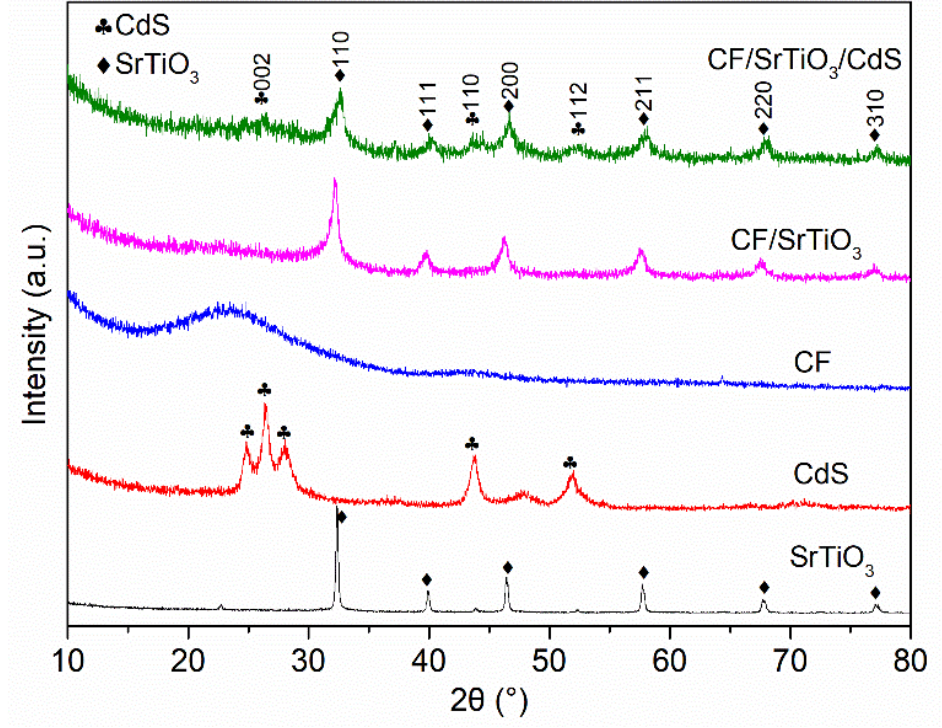
Figure 1. XRD energy spectra of samples.